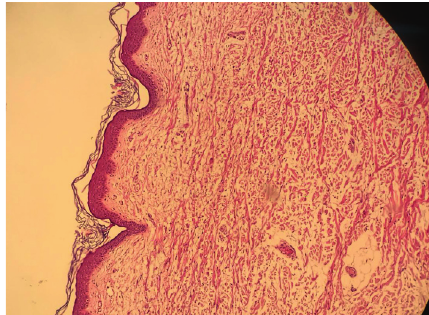
Figure 3: Dermal infiltration of spindle cells in a collagenous stroma containing abundant mucin intermixed with some mast